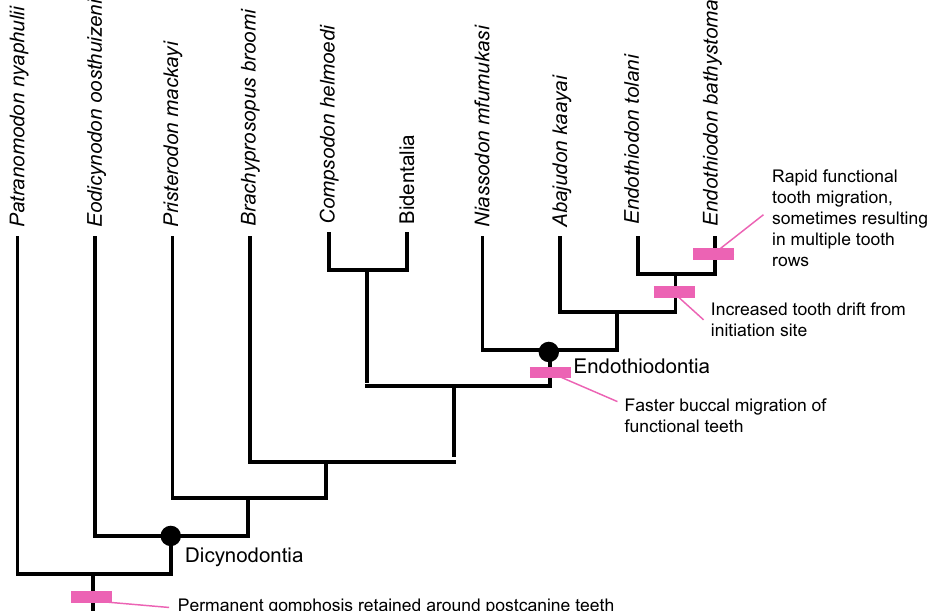
Figure 13. Cladogram illustrating changes in tooth replacement across stemward dicynodonts. Phylogeny based on Olroyd et al. 47 , Kammerer and Ordoñez 106 , and Angielczyk et al. 107 , but note that other topologies for Pristerodon, Brachyprosopus , the endothiodonts, and the emydopoids have appeared in recent phylogenetic analyses 42,108,109